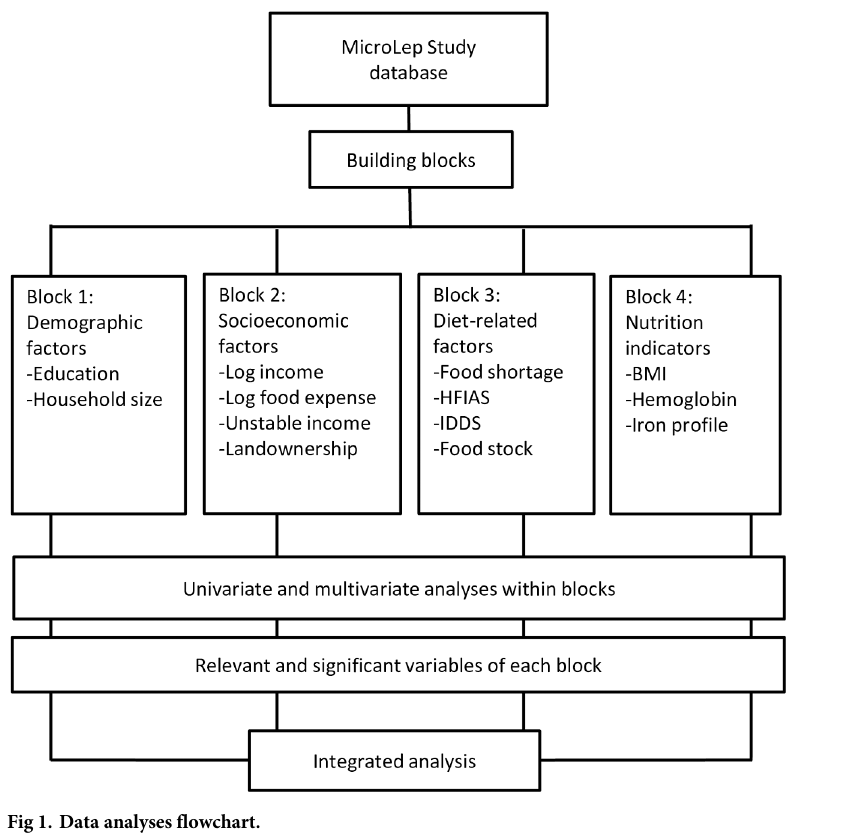
Fig 1. Data analyses